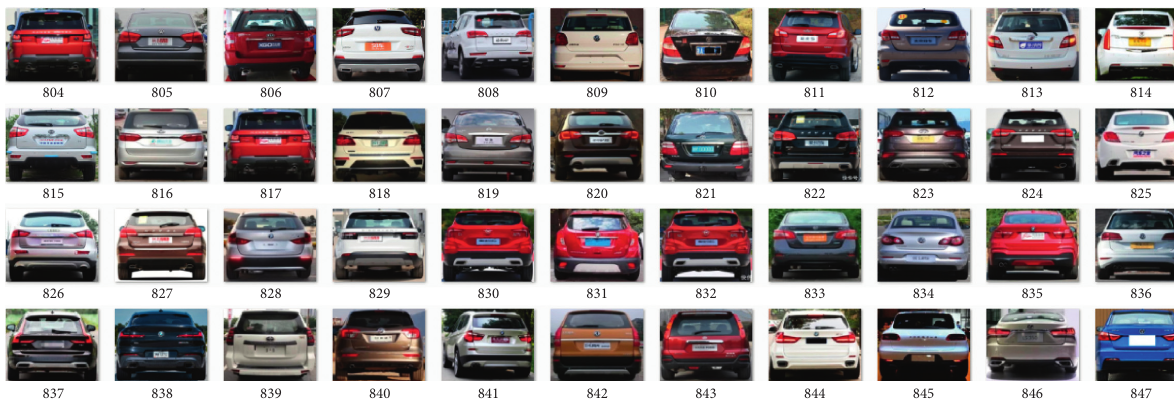
Figure 14: Partial vehicle sample